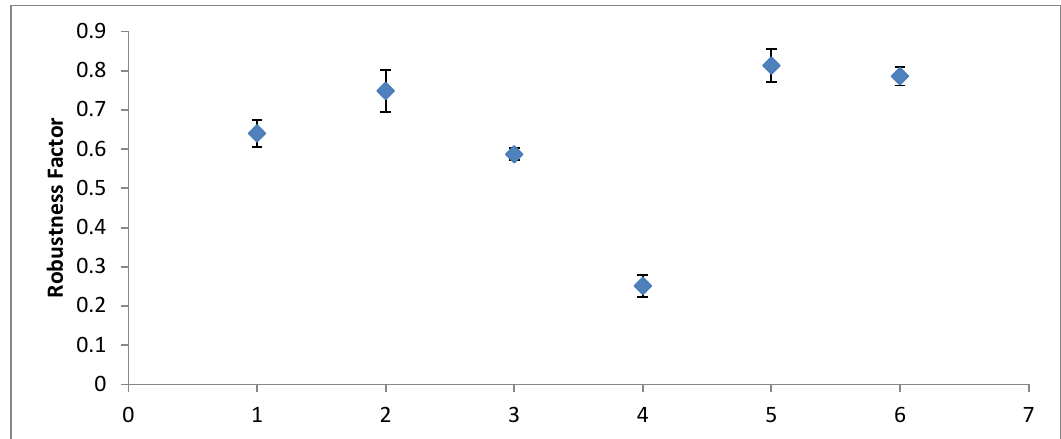
Figure 8. The degree of robustness of each set of samples. 1—TEA Uncovered, 2—TEA Melinex, 3—TEA UV Protection, 4—MDEA Uncovered, 5—MDEA Melinex, 6—MDEA UV Protection.